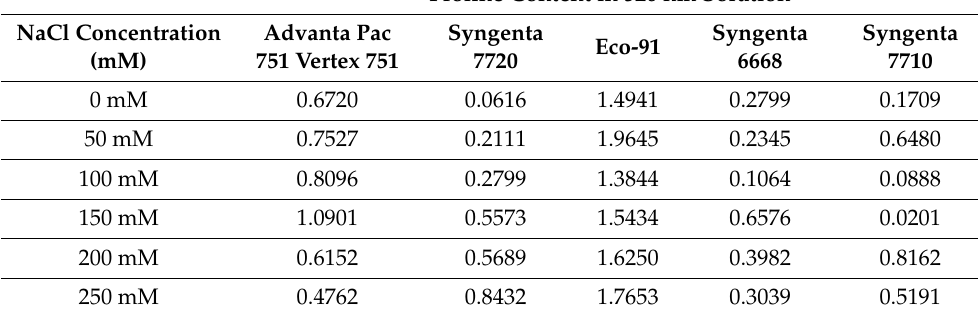
Table 1. (Proline